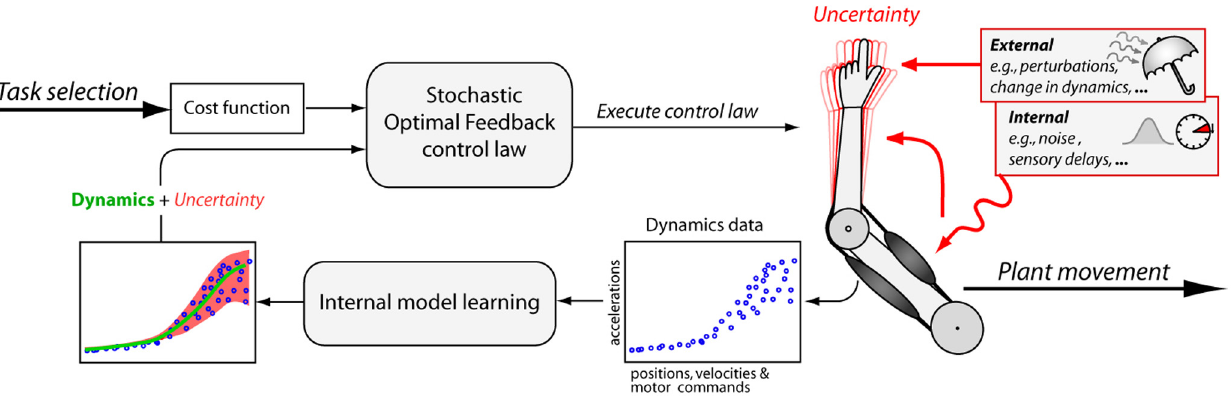
Figure 1. Schematic representation of our OFC-LD approach. The optimal controller requires a cost function, which here encodes for reaching time, endpoint accuracy, endpoint velocity (i.e., stability), and energy efficiency. Further a forward dynamics function is required, which in OFC-LD is learned from plant feedback directly. This learned internal dynamics function not only allows us to model changes in the plant dynamics (i.e., adaptation) but also encodes for the uncertainty in the dynamics data. The uncertainty itself, visible as kinematic variability in the plant, can originate from different sources, which we here classify into external sources and internal sources of uncertainty. Most notably OFC-LD identifies the uncertainty directly from the dynamics data not making prior assumptions about its source or shape.